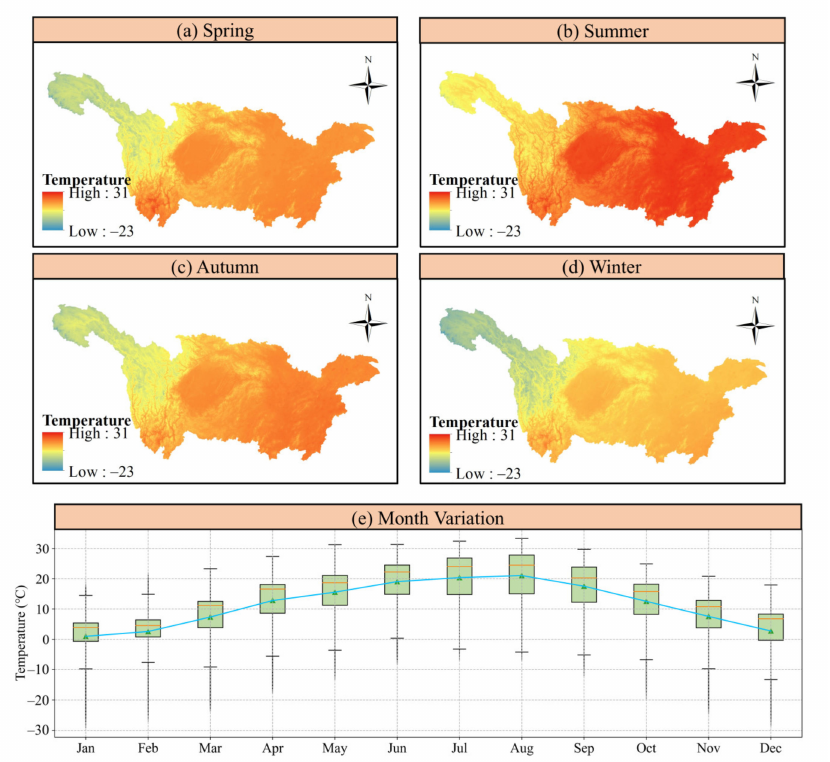
Figure 9. The spatial distributions of average downscaled temperature during each season in 2019. ( a – d ) are the spatial distributions of downscaled temperature in four seasons. ( e ) exhibits the temporal variation of downscaled temperature in each